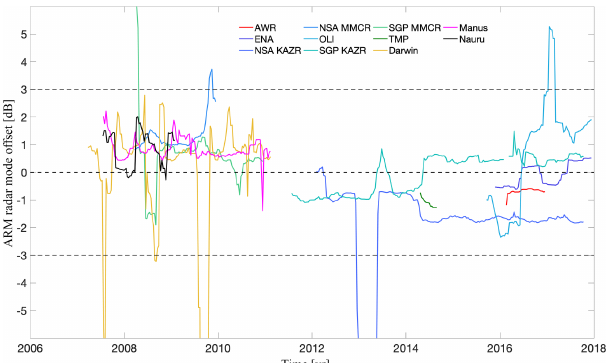
Figure 2. The difference (dB) in the radar reflectivity reported be- tween different ARM modes. For KAZR/KAZR2 systems the GE– MD difference and for MMCR systems the mode 3–mode 2 differ- ences are